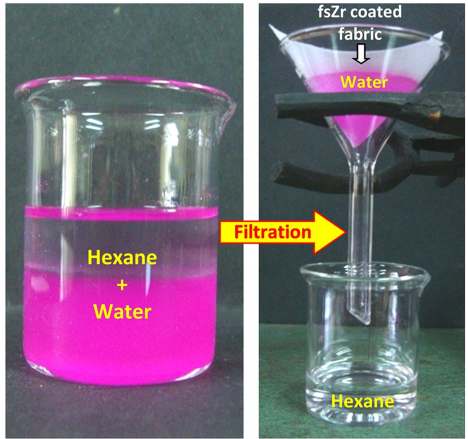
Figure 15. Hexane-water separations (Reproduced from [137], under a Creative Commons Attribution 4.0 International License).